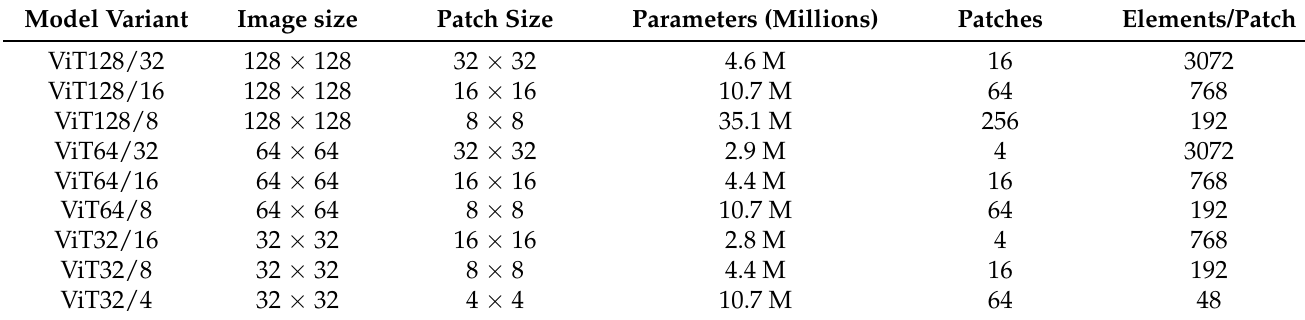
Table 3. Conditional settings of Vision Transformer.